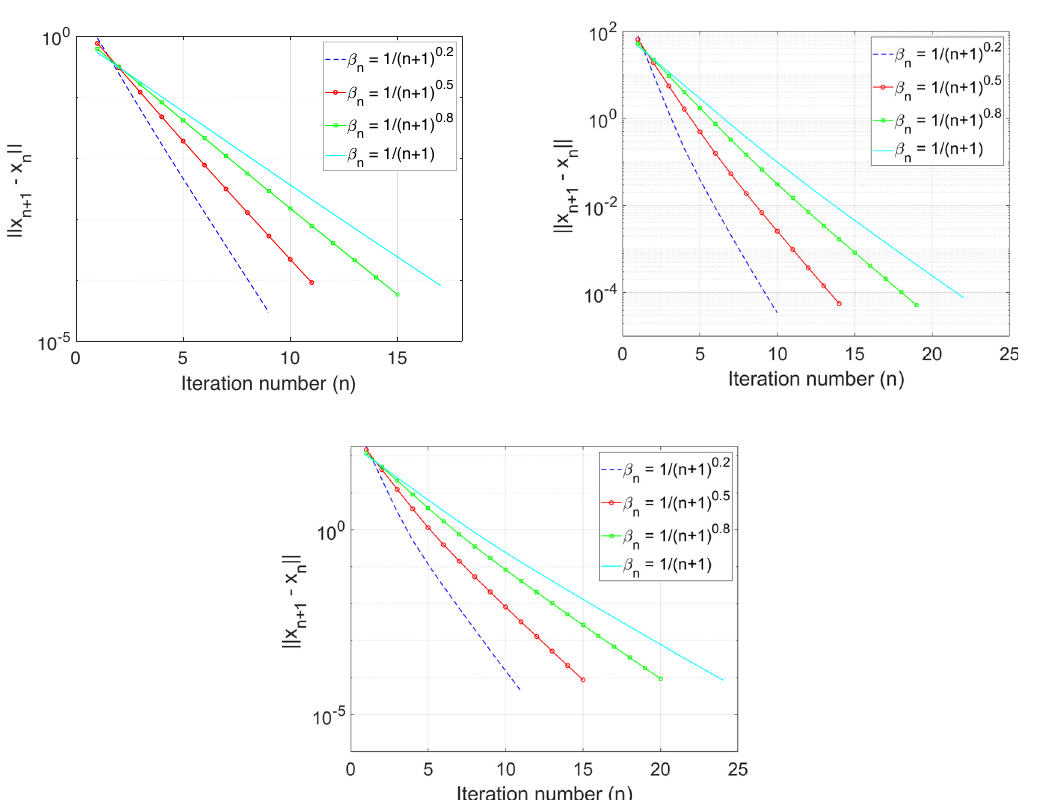
Figure 1: Example 4.1, Experiment 1, top left: = m 10 ; top right: = m 20 ; bottom: = m 30 .